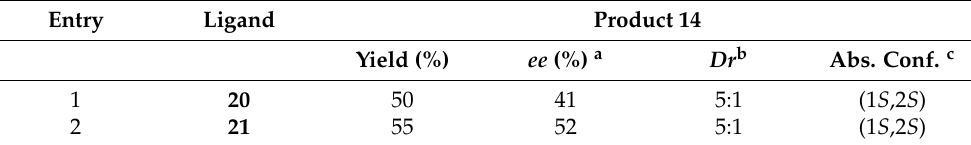
Table 6. Diethylzinc addition to benzaldehyde catalyzed by phosphine oxides 20 and 21 . Entry Ligand